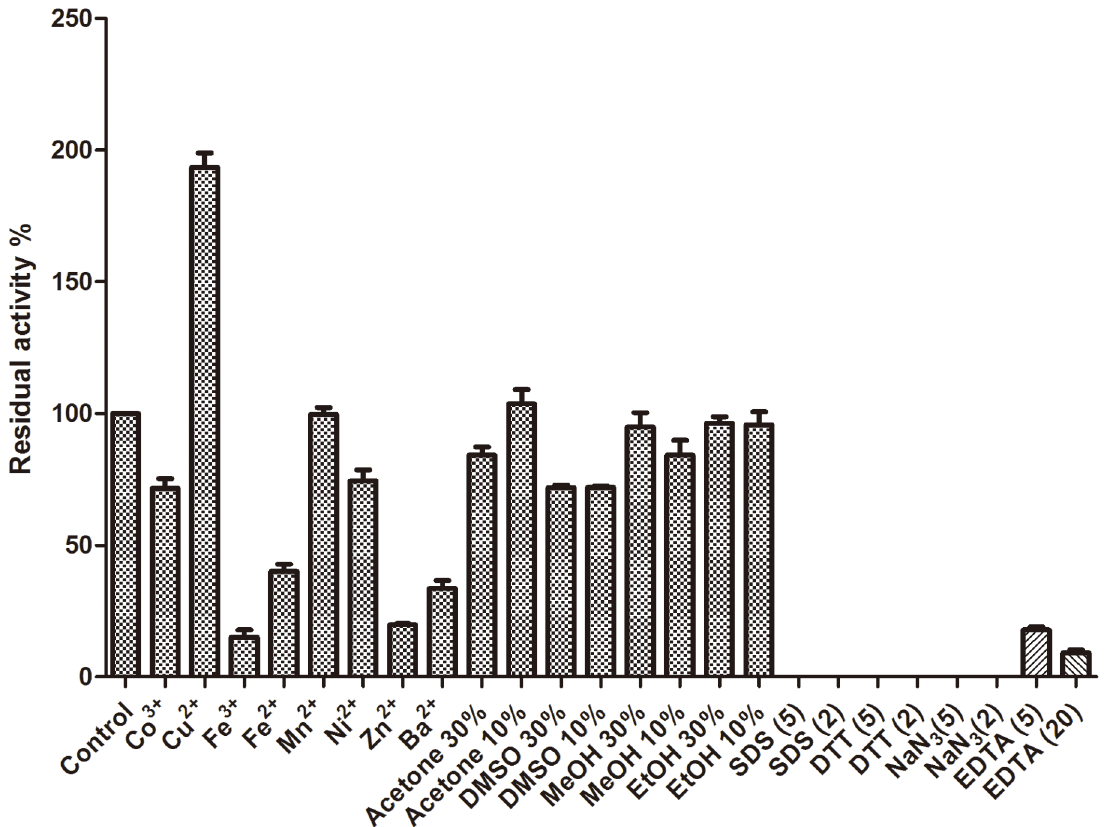
Fig 4. Effect of heavy metals, organic solvents and enzyme inhibitors on enzymatic stability of Atm. DMSO: dimethyl sulfoxide; MeOH: methanol; EtOH: ethanol; SDS: sodium dodecyl sulfate; DTT: dithiothreitol; EDTA: ethylene diamine tetraacetie acid; NaN 3 : sodium azide. Error bars represent the standard errors of the